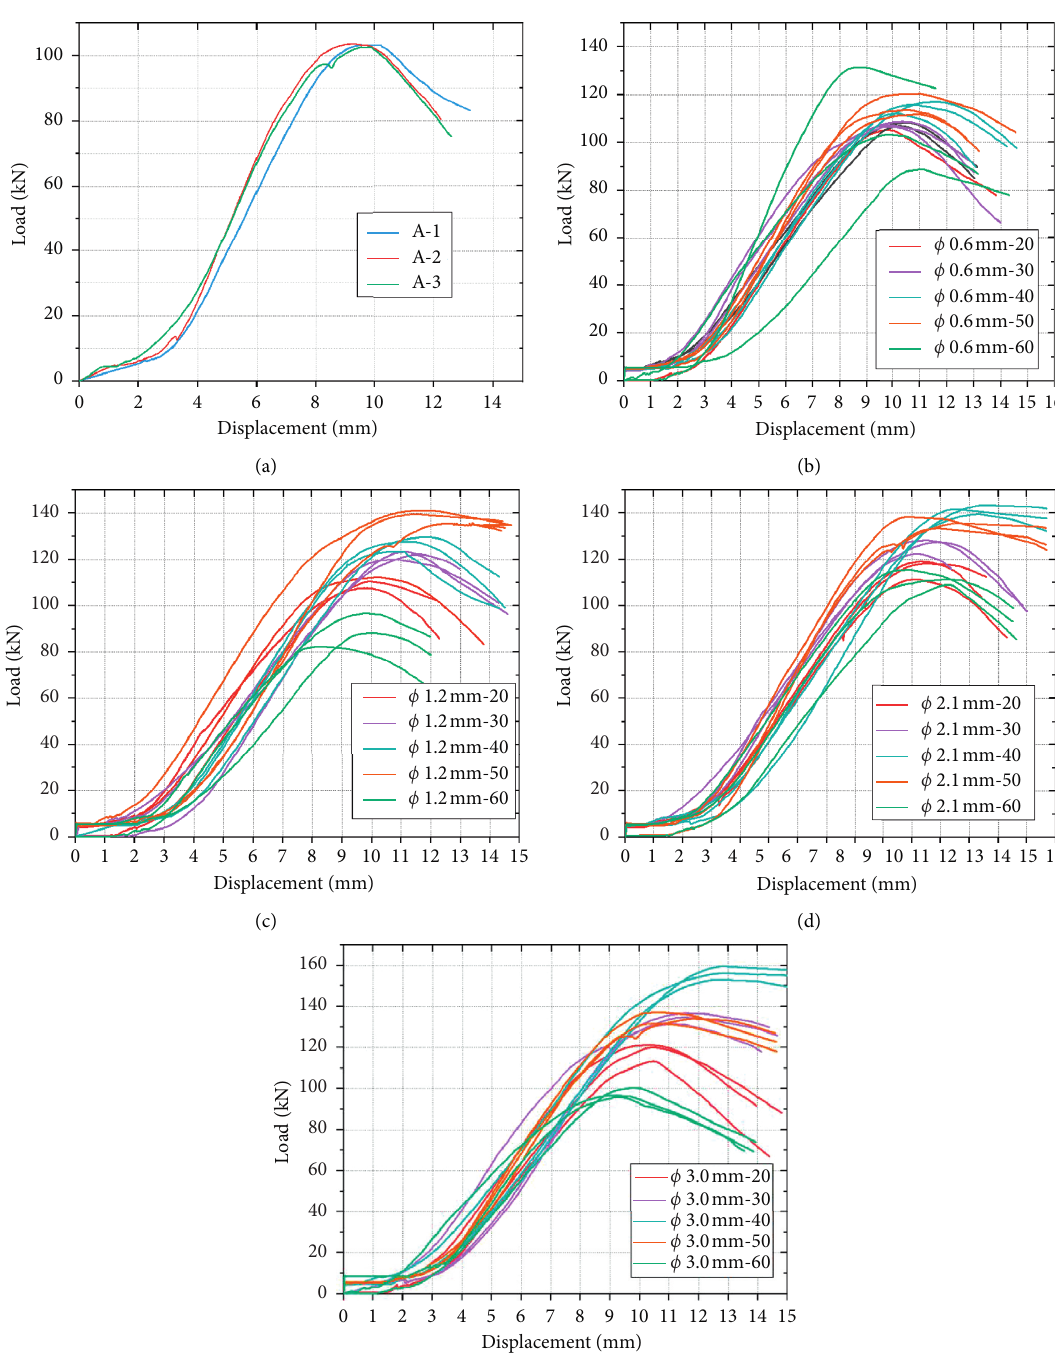
Figure 17: Load-displacement curves for each specimen from which data were measured for groups A–E: (a) load-displacement curves of pure resin grout, (b) load-displacement curves from group B; (c) load-displacement curves from group C; (d) load-displacement curves from group D; (e) load-displacement curves from group